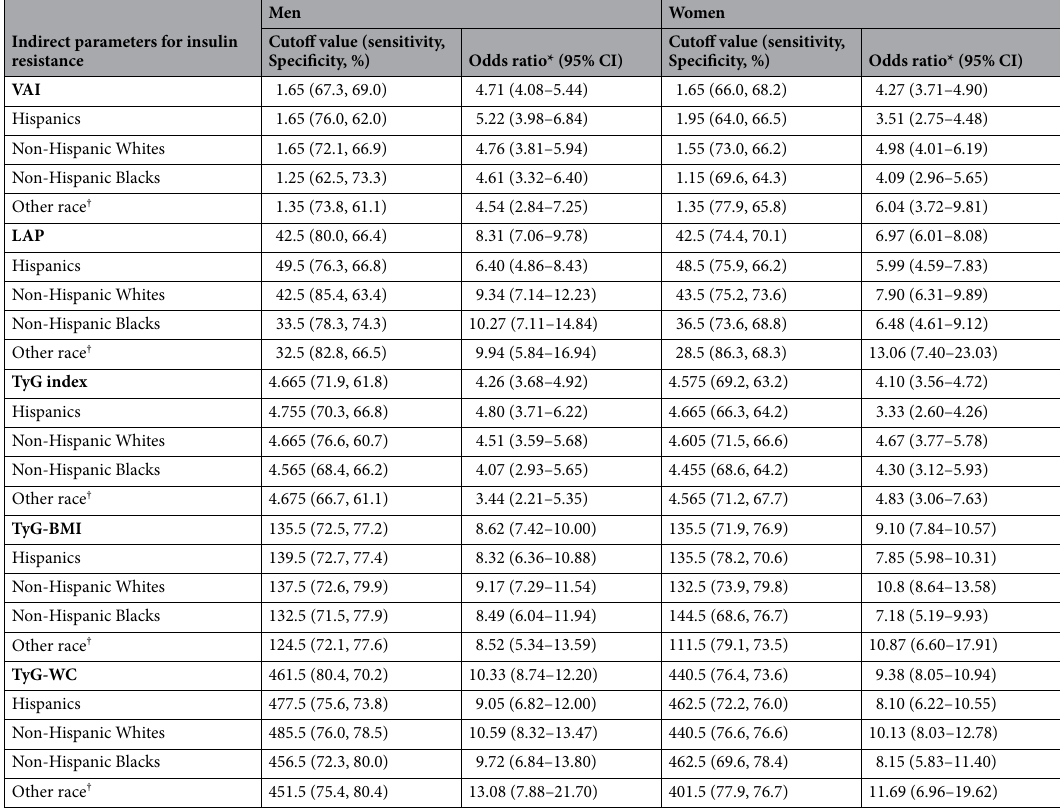
Table 4. Cutoff values for each parameter and their corresponding sensitivity, specificity, and odds ratios for insulin resistance. HOMA-IR homeostasis model assessment-insulin resistance, VAI visceral adiposity index, LAP lipid accumulation product, TyG index triglycerides and glucose index, BMI body mass index, WC waist circumference. *Adjusted for Age, race, smoking status, and blood pressure. † Other race included non- Hispanic Asian and multi-racial